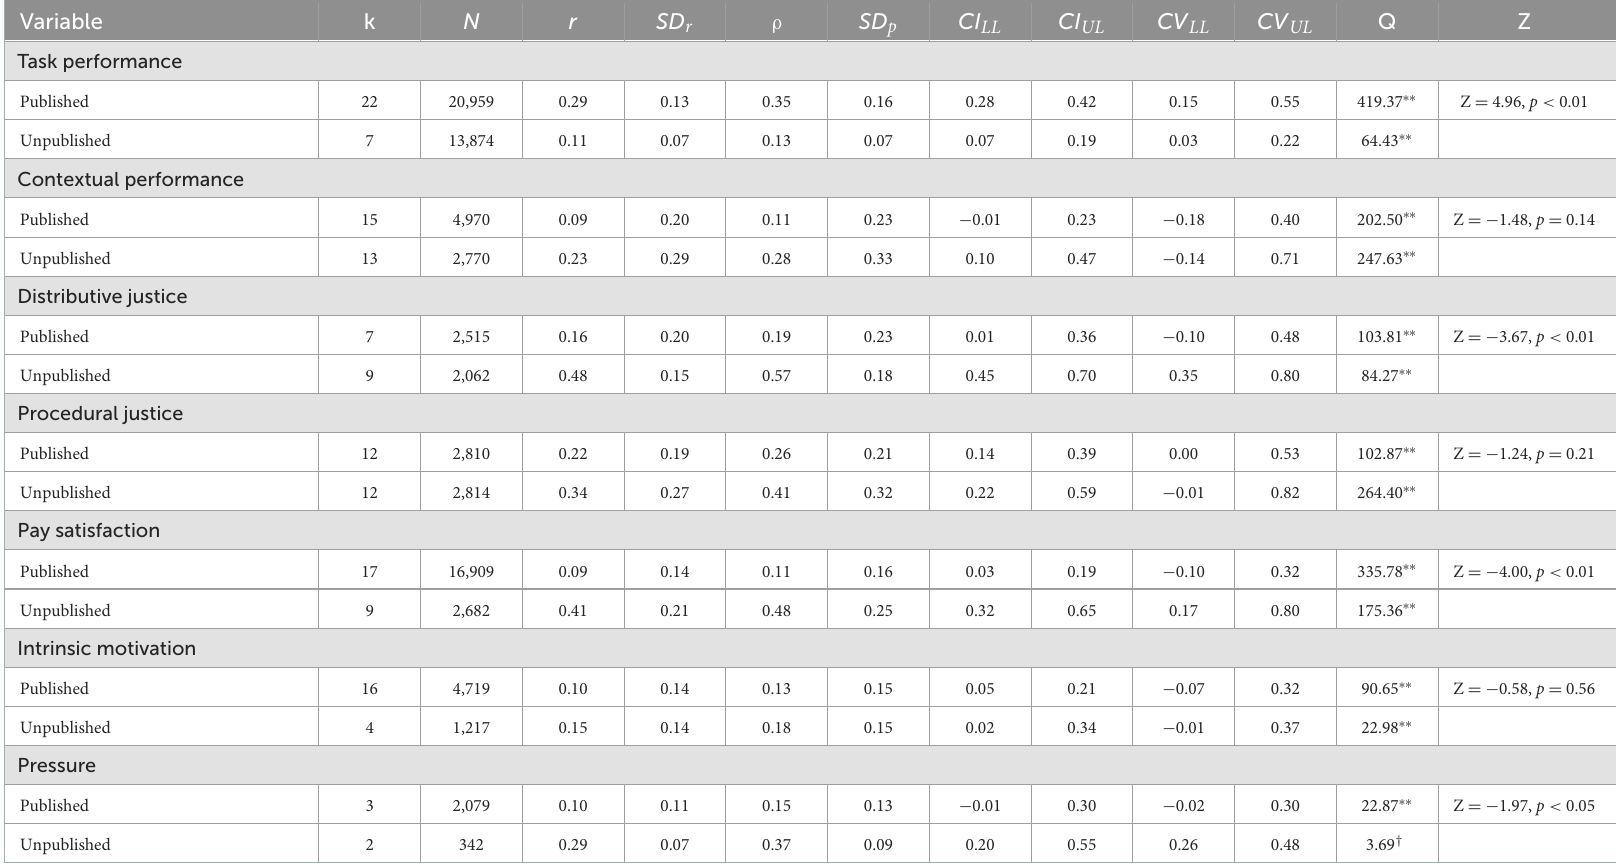
TABLE 8 Moderating effect of publication status on relationships between PFP and